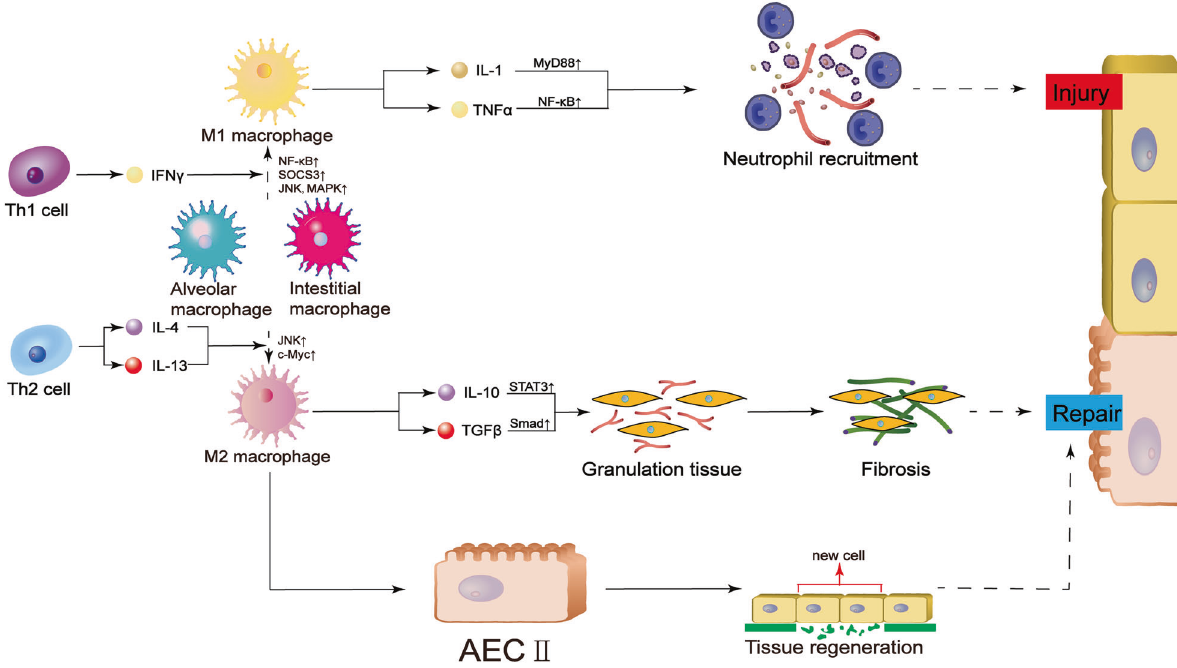
Fig. 2 Role of macrophages in ALI. The progression of ALI is in fl uenced by alveolar and interstitial macrophage polarization. T helper 1-mediated production of IFN γ induces M1 polarization, with increased transcription of NF- κ B, SOCS3, JNK and MAPK. M1 macrophages promote neutrophil recruitment either through phagocytosis and subsequent cell damage or through cytokine secretion and transcription factor activation. IL-4 and IL-13 polarize alveolar macrophages towards the M2 phenotype by regulating the transcription of JNK and c-Myc. M2 macrophages secrete cytokines that induce fi brosis or stimulate new cell regeneration. Both processes promote tissue repair. IFN interferon, TNF tissue necrosis factor, MyD88 myeloid differentiation primary response 88, NF- κ B nuclear factor-kappaB, JNK c-Jun N-terminal kinase, AECII type II alveolar epithelial